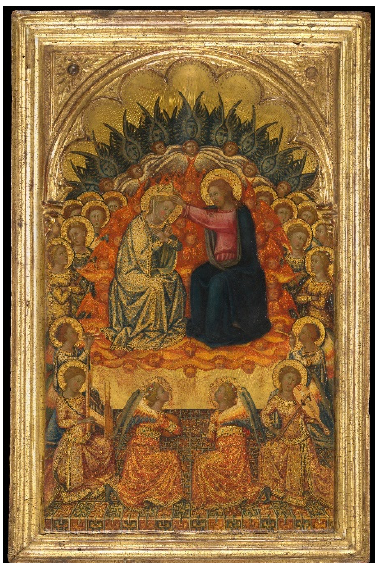
Figure 1. The Master of the Washington Coronation, The Coronation of the Virgin , c. 1333–1362. Na- tional Gallery of Art, Washington, DC.